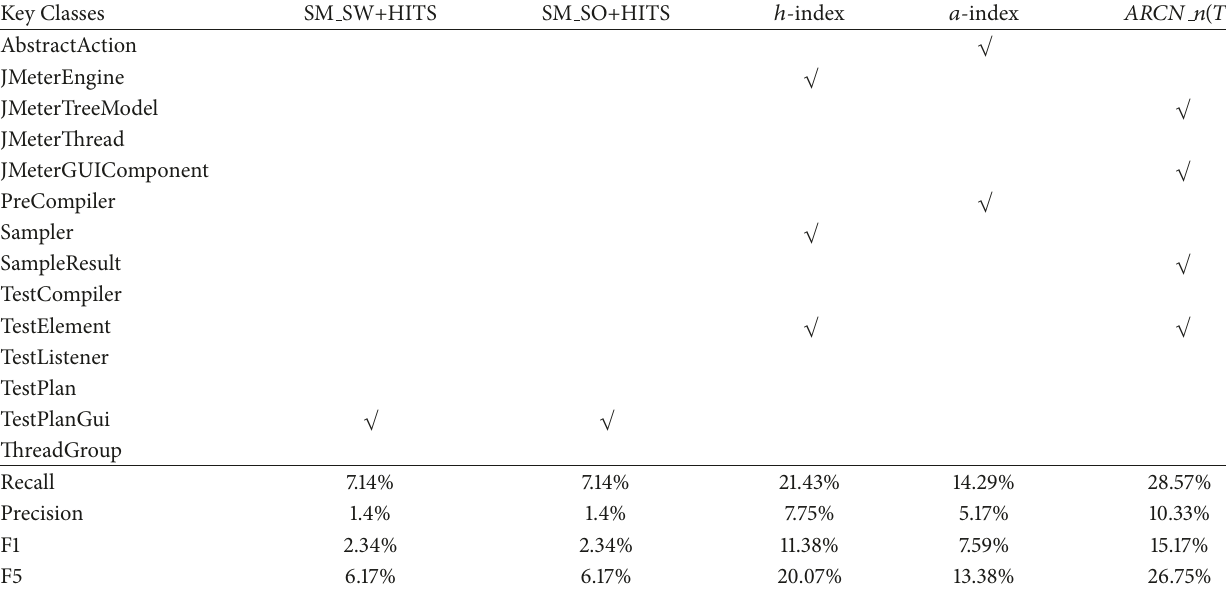
Table 7: Comparison of the results obtained by the approaches applied to JMeter.